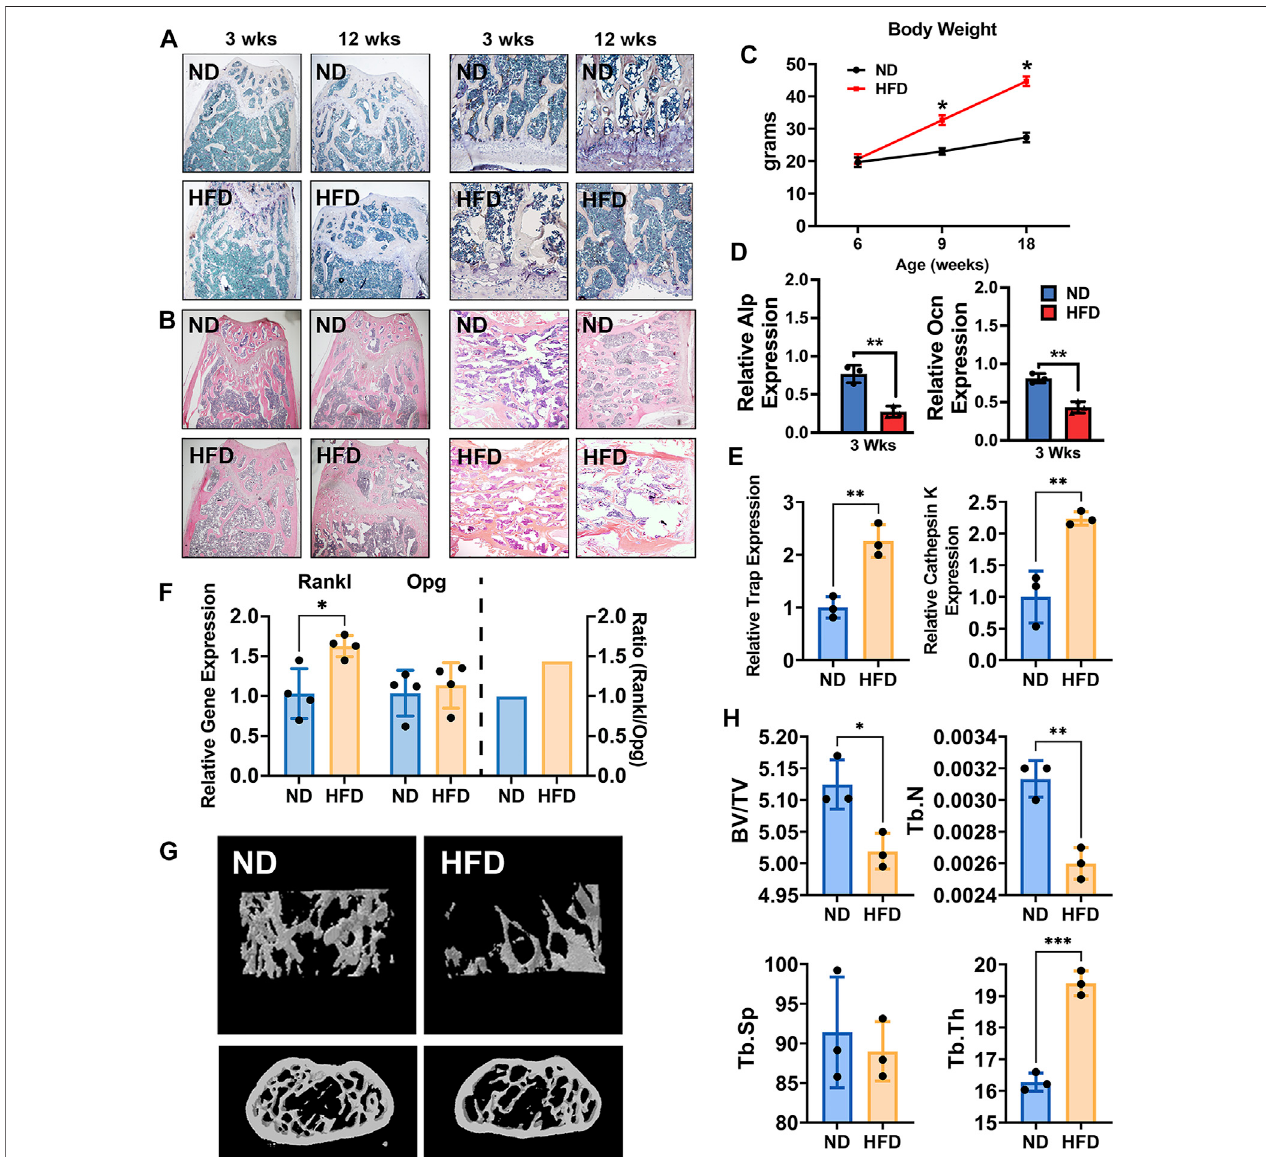
FIGURE 1 | High-fat diet (HFD) leads to bone loss and alters bone metabolism in adult mice. (A) TRAP staining of femurs (left two panels) and vertebrae (right panels) of normal diet (ND) mice (18-week-old with ND) and HFD mice (18-week-old with 12 weeks of HFD). (B) H&E staining of femurs (left two panels) and vertebrae (rightpanels)ofNDmice(18-week-oldwithND)andHFDmice(18-week-oldwith12 weeksofHFD)at18 weeksofage. (C) Thebodyweightcurve.MaleC57BL/6JDIO micewerefedHFD(60kcal%fat)andcontrolmicewerefednormaldiet(ND,10kcal%fat)betweentheagesof6and18 weeks n =4.Datawereshownasmean± S.D. (D) The mRNA expression of ALP (upper) and Ocn (lower), as detected by qRT-PCR in femurs of HFD and ND mice (3 weeks of HFD, n = 3). (E) The mRNA expression ofTRAP and cathepsin K in femurs of HFD and ND mice (12 weeks ofHFD, n = 3). (F) The mRNA expression of Opg and Rankl, as detected by qRT-PCR in femursofHFDandNDmice(12 weeksofHFD, n =4). (G) Representativeimagesasdetectedandreconstructedbymicro-CTandCtansoftwareinthefemurofHFDand ND mice (12 weeks of HFD). (H) Histomorphometric analysis of micro-CT reconstruction of distal femurs, as measured by Ctan software, n = 3. Data were shown as mean ± S.D., two-tail t -test was used to test for those data between two groups. * p < 0.05; ** p < 0.01; *** p < 0.001; **** p < 0.0001.